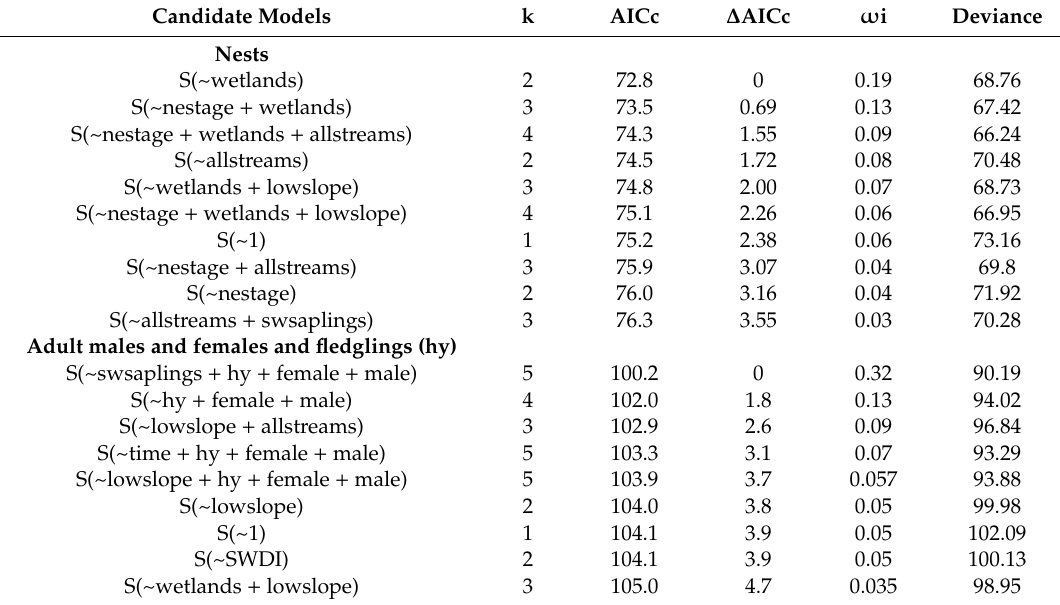
Table 4. High-ranking candidate models for rusty blackbird fledgling , adult , and nest survival in northern New Hampshire. k = number of parameters, AICc = Akaike information criterion adjusted for small sample sizes, ∆ AICc is the di ff erence between the model and the top model, ω i = weight, and cum. ω i = cumulative weight; see Table 1 for habitat variable descriptions. nestage is the age of the nest when first found, S = survival, time = time from first day of study, hy = fledgling, SWDI = Swift Diamond drainage.